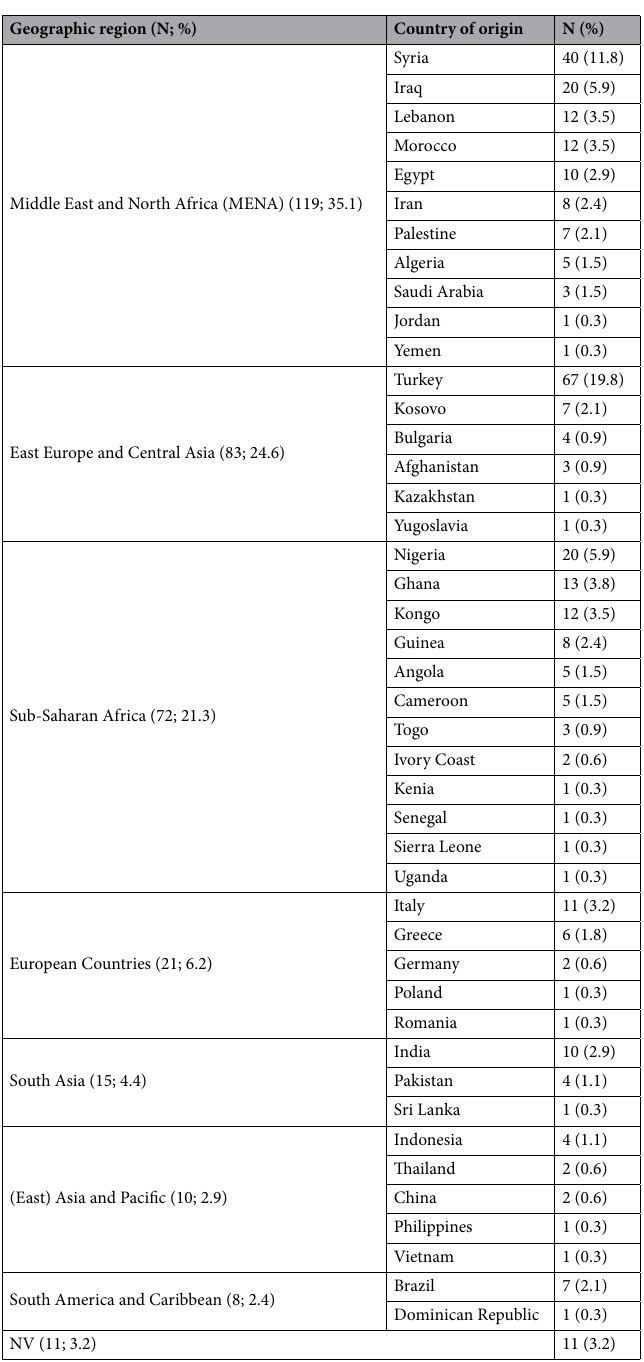
Table 1. Migration background among patients with hemoglobinopathies diagnosed at the Pediatric and Adult Hemoglobinopathy Outpatient Units (PAHOs) of the University Hospital Essen between August 2018 to September 2021 (N = 339). MENA Middle East and North Africa, NV no